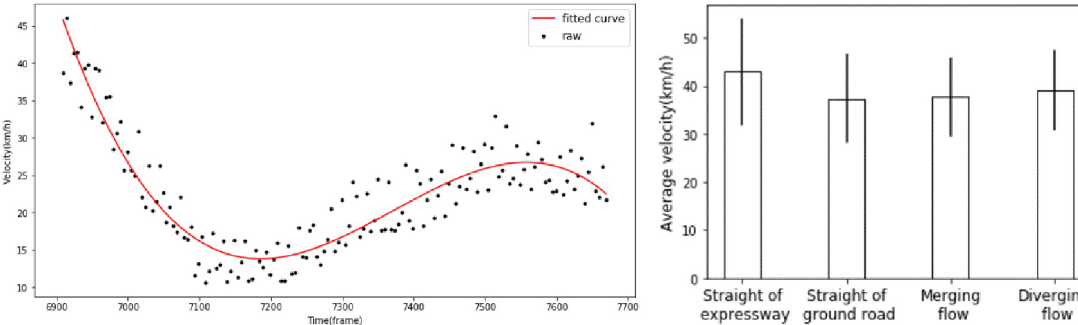
Fig 4. Velocity fitting diagram and velocity statistical feature